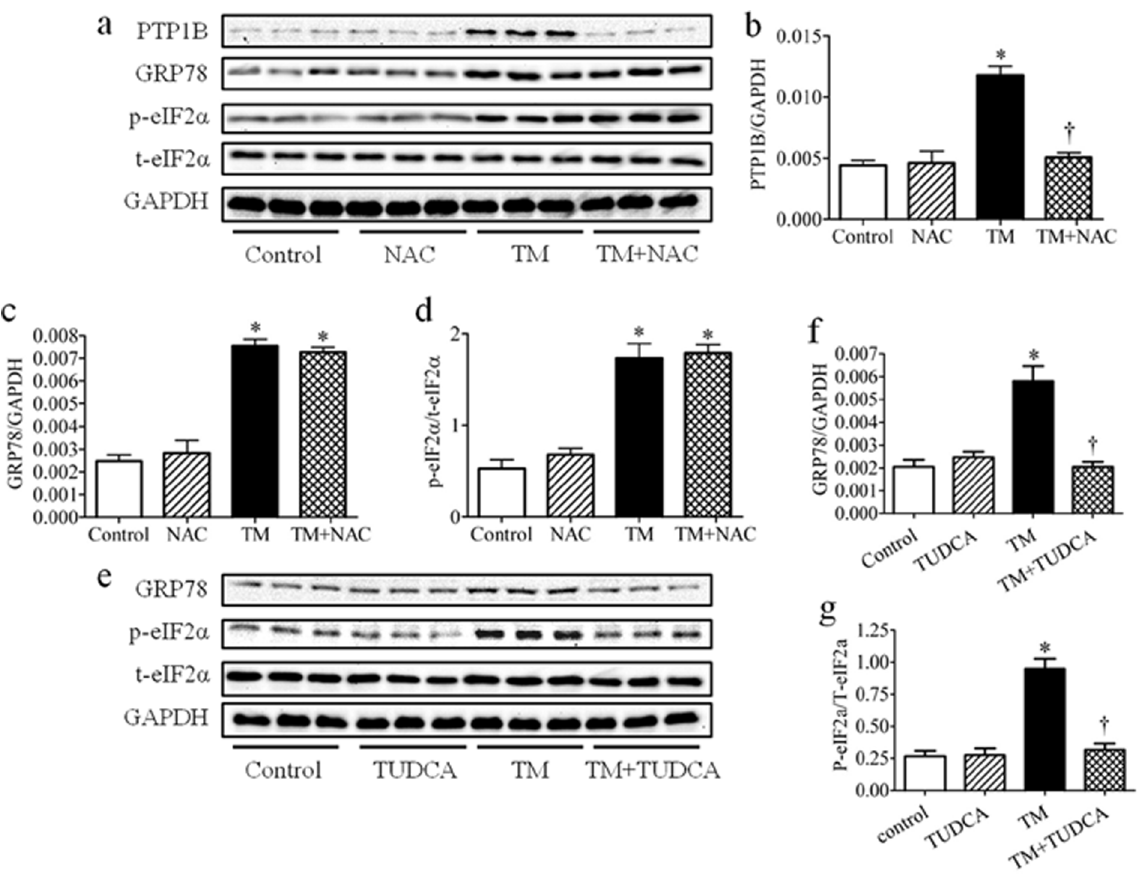
Figure 7. The role of ROS in tunicamycin (TM)-induced PTP1B protein expression in C2C12 myotubes. (a–d) Representative Western blots (a) and densitometric analysis (n=6) of PTP1B (b), GRP78 (c), and phospho- and total-eIF2 a (p-eIF2 a and t-eIF2 a , respectively) (d) protein levels in C2C12 myotubes treated with tunicamycin in presence of 10 mmol/l NAC for 24 hours. (e–g) Representative Western blots (e) and densitometric analysis (n=6) of GRP78 (f), and p-eIF2 a and t-eIF2 a (g) protein levels in C2C12 myotubes treated with tunicamycin in presence of 1 mmol/l TUDCA for 24 hours. * p , 0.05 compared with non-treated control cells, { p , 0.05 compared with tunicamycin-treated cells.